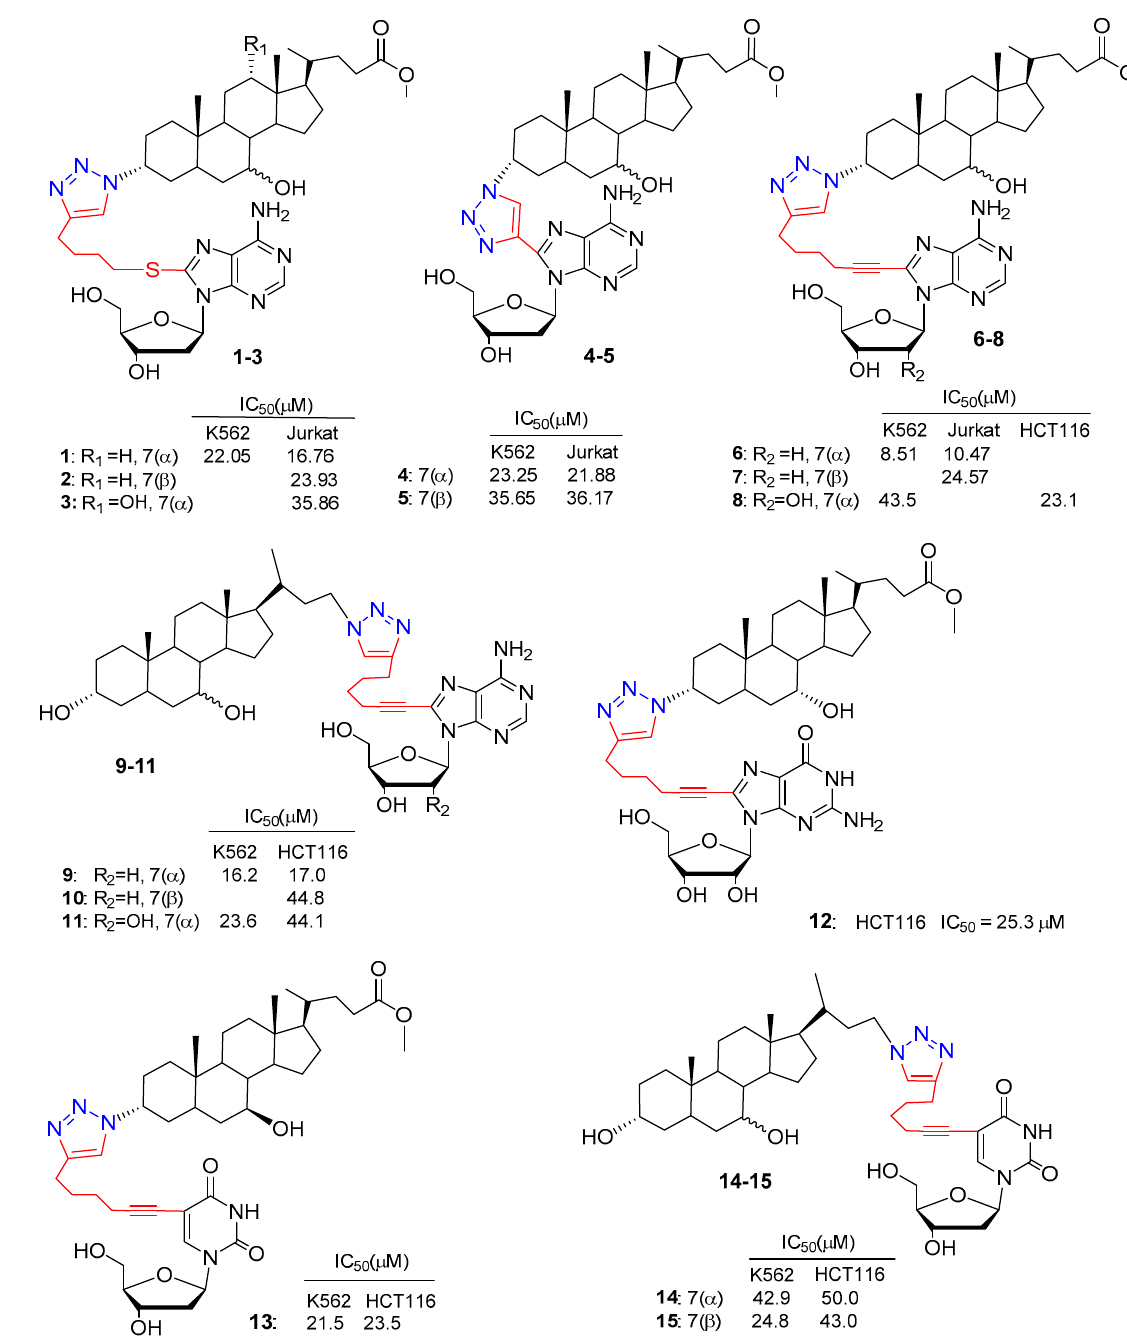
Figure 3. Cytotoxic activity of several BA-nucleoside hybrids linked via 1,2,3-triazole moiety.